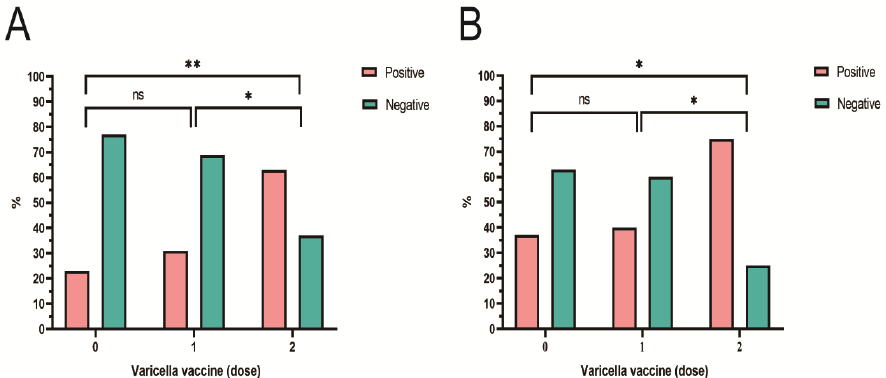
Figure 2. ( A ) Seroprevalence of anti-VZV IgG in VarV-vaccinated participants in Zhanjiang; ( B ) seroprevalence of anti-VZV IgG in VarV-vaccinated participants in Heyuan. %, the propor- tion of the participants with anti-VZV IgG; 0, non-vaccinated group; 1, one-dose-vaccinated group; 2, two-dose-vaccinated group; ns, p > 0.05; * p < 0.05; ** p < dose-vaccinated group; ns, p > 0.05; * p < 0.05; ** p < 0.01. Table 2. The coverage of the varicella vaccine for participants aged 1 – 14 years in both cities.